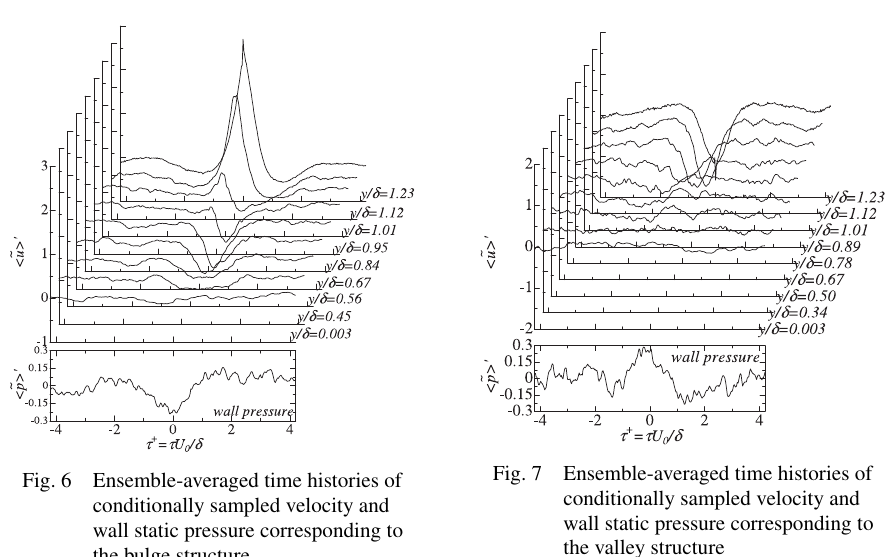
Fig. 6 Ensemble-averaged time histories of conditionally sampled velocity and wall static pressure corresponding to the bulge structure